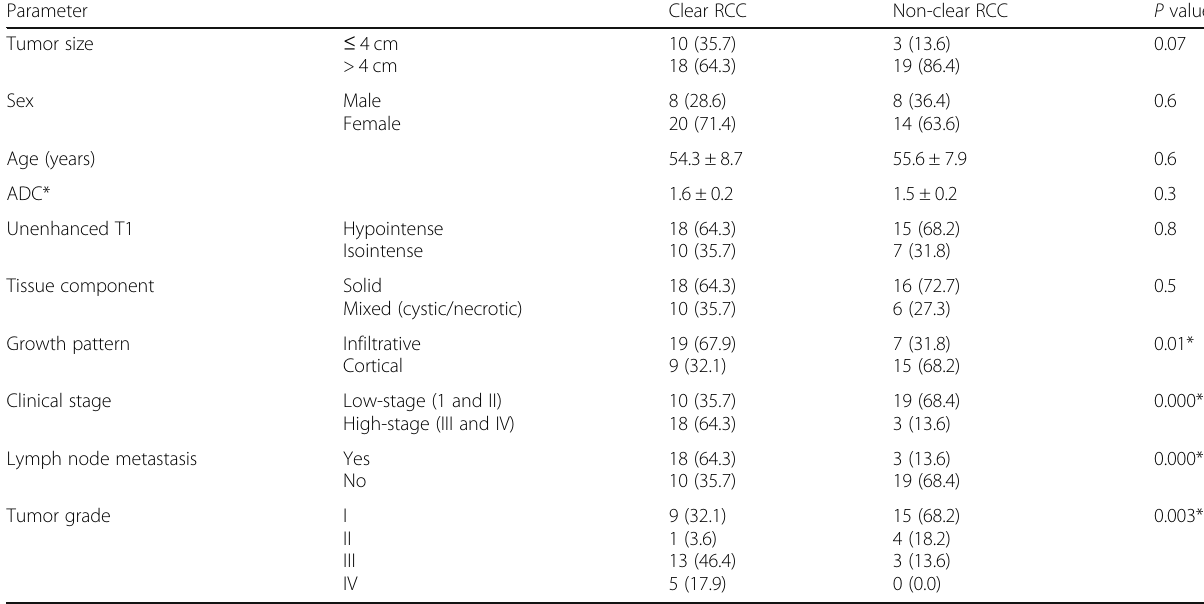
Table 2 Features of prognostic factors of 28 clear and 22 non-clear RCC Parameter Clear